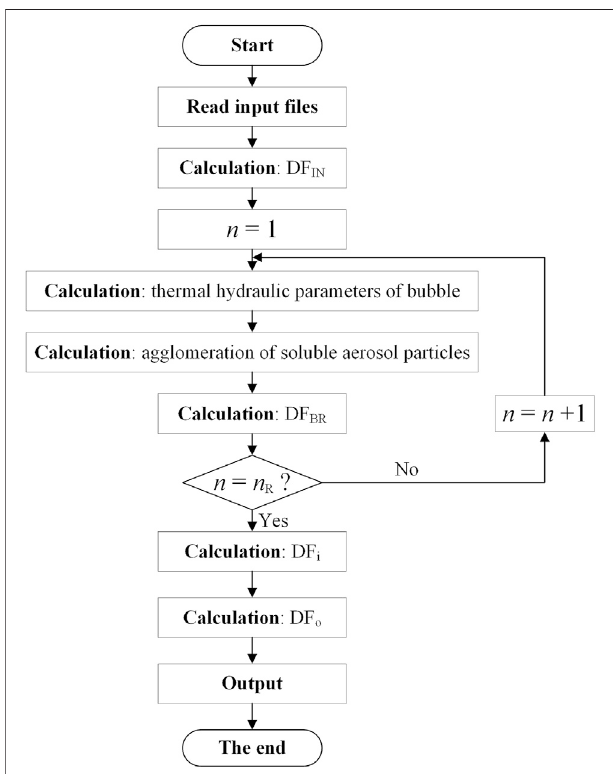
FIGURE 2 | Flowcharts for aerosol pool scrubbing simulation.